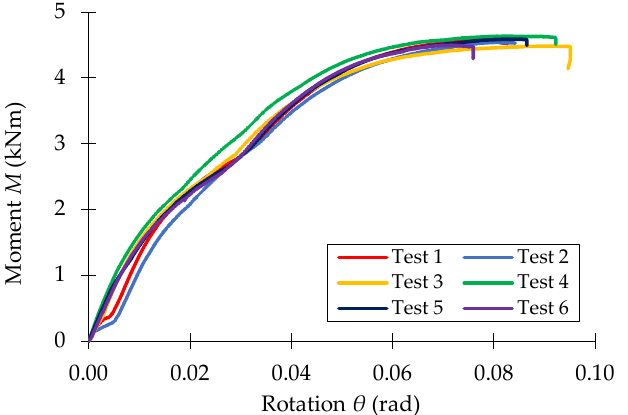
Figure 11. Moment-rotation curve ( M − θ ) recorded in bending tests for the beam-connector-upright assembly of type 0-II-5T.